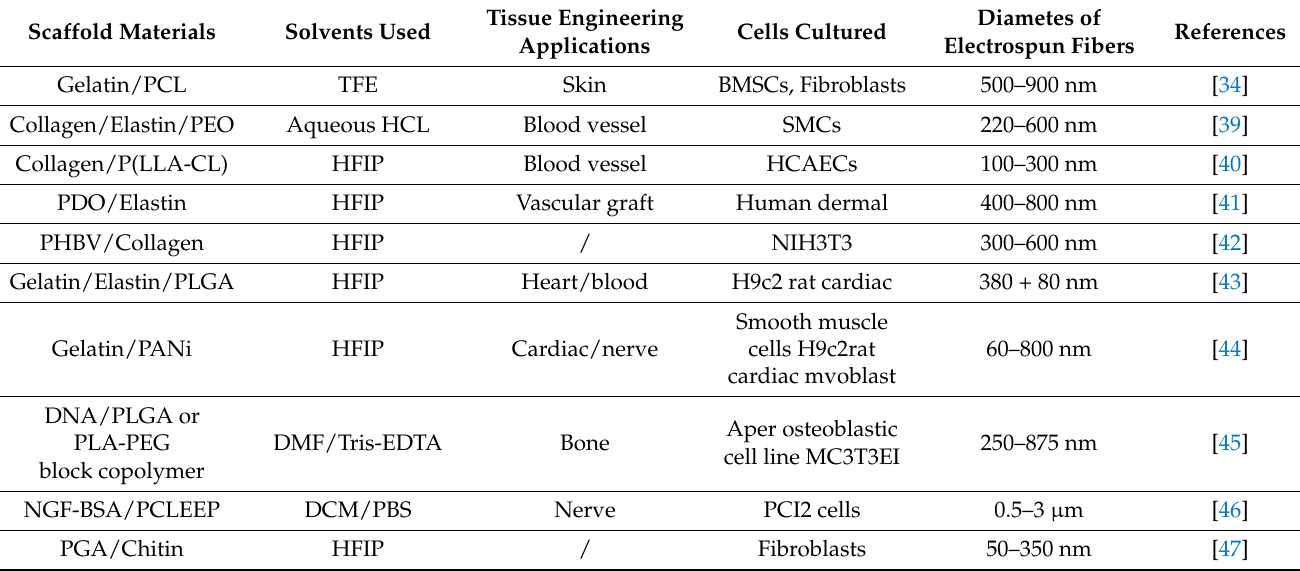
Table 1. Organic–organic composite material with